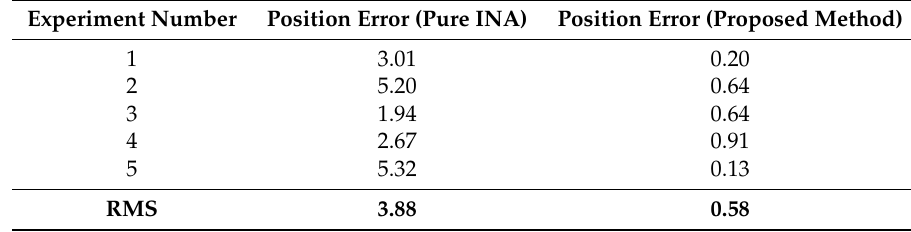
Table 3. Final position error comparison in the U shaped corridor walking (unit: